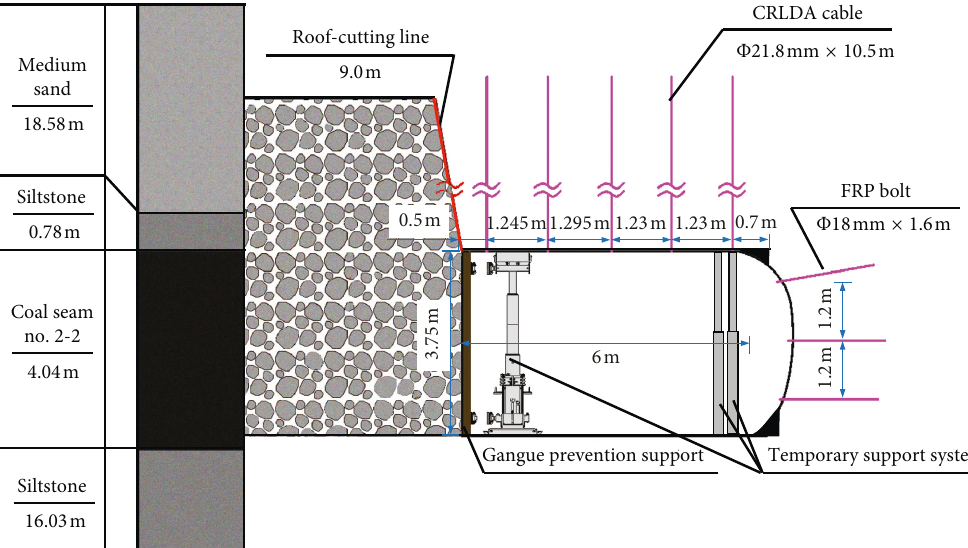
Figure 2: Design of the roof-cutting line and support parameters in GEFANM.